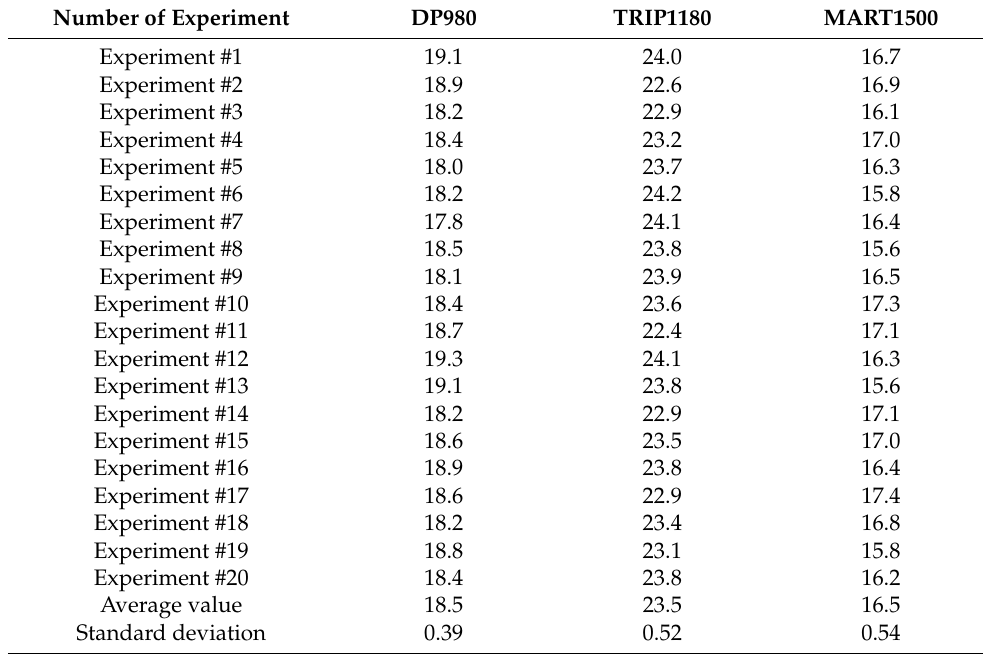
Table 4. Measured HER by applying punch load analysis in machine vision system.